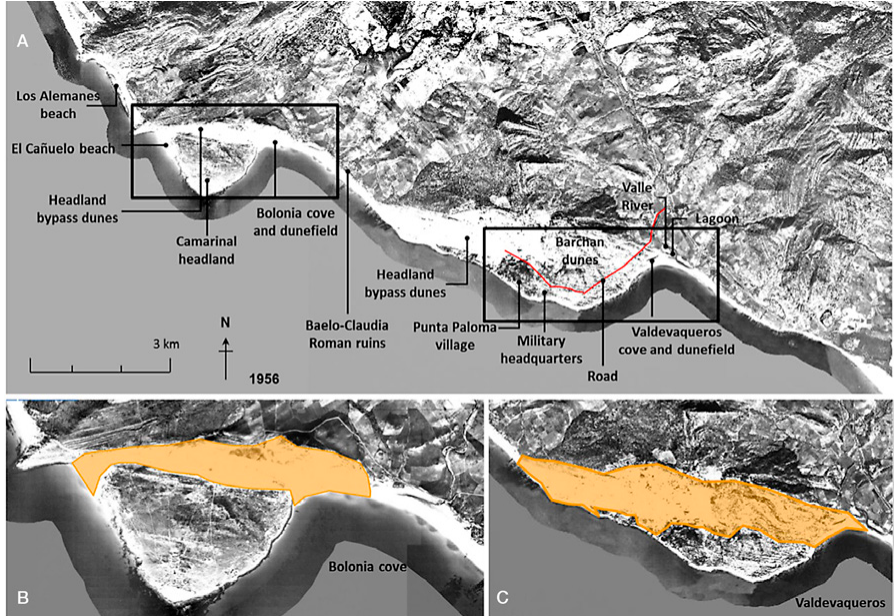
Fig. 2. – A, aerial photograph from the American flight in 1956, where the formation of a former bypass dunefield can be seen from Val- devaqueros to Bolonia. B, area of the Bolonia former bypass dunefield (90 ha). C, area of the Valdevaqueros former bypass dunefield (440